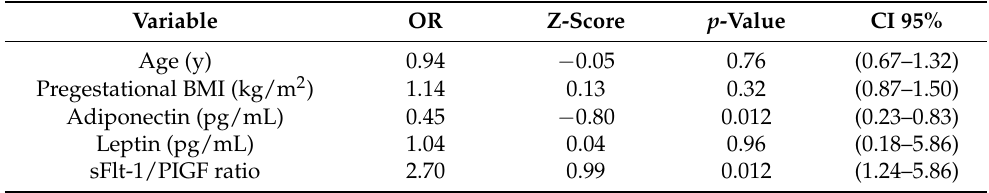
OR: odds ratio; 95% CI: 95% confidence